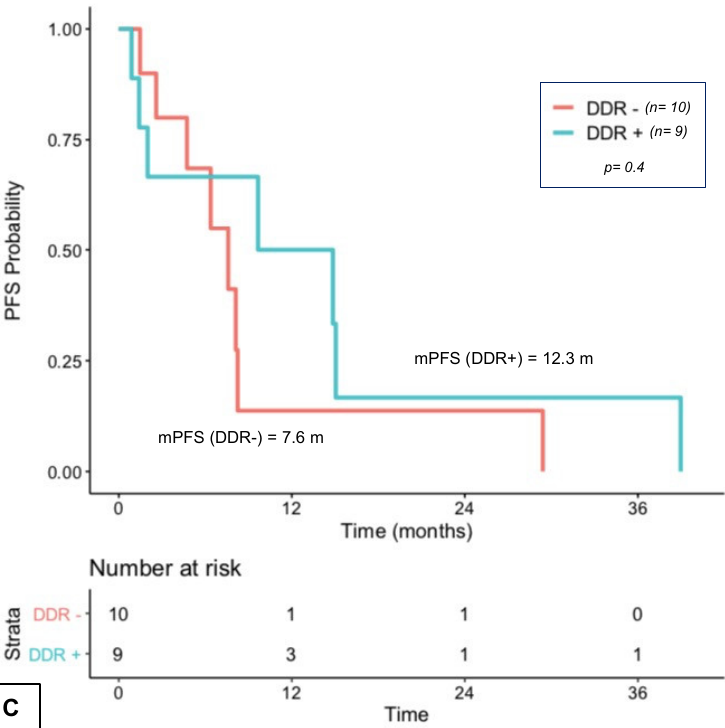
Figure 2. First-line treatment mCRPC PFS according to somatic DDR+ vs. DDR − alterations ( A ), according to ATM/B1/B2-mutated patient vs. other patients ( B ). DDR+: mutated patients; DDR − : non-mutated patients; m: months; mCRPC: metastatic castration-resistant prostate cancer; PFS: progression-free survival; n: number of patients. ( C ) First-line treatment mCRPC PFS according to somatic DDR+ vs. DDR − alterations among patients who received taxanes. DDR+: mutated patients, DDR − : non-mutated patients; m: months; mCRPC: metastatic castration-resistant prostate cancer; mPFS: median progression-free survival; n : number of patients.